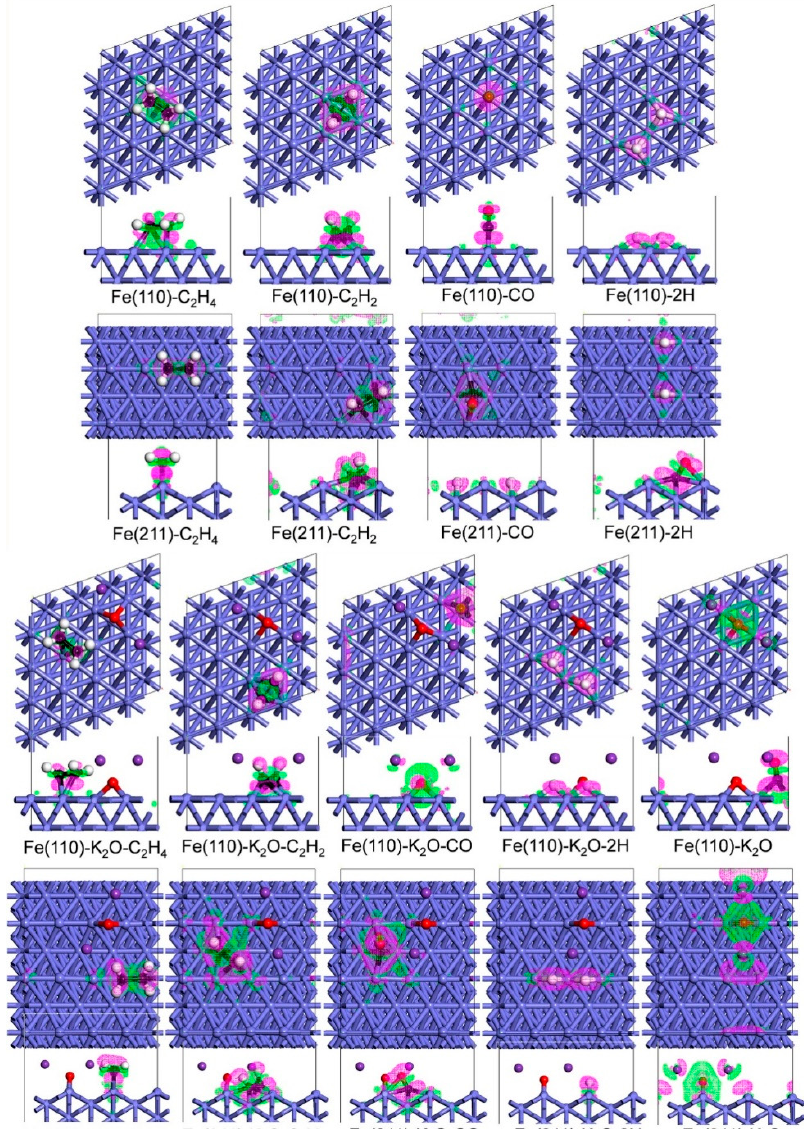
Figure 2. The charge density di ff erences of surface adsorbed C 2 H 4 , C 2 H 2 , CO, H 2 and K 2 O on the two models of Fe(110), Fe(211), Fe(110)-K 2 O and Fe(211)-K 2 O, the Fe, K, O, C and H atoms are given in grayish blue, purple, red, black and white, respectively; pink and green areas represent charge density accumulation and depletion, respectively; the cuto ff of iso-surfaces is 0.005 electrons Å − 3 .